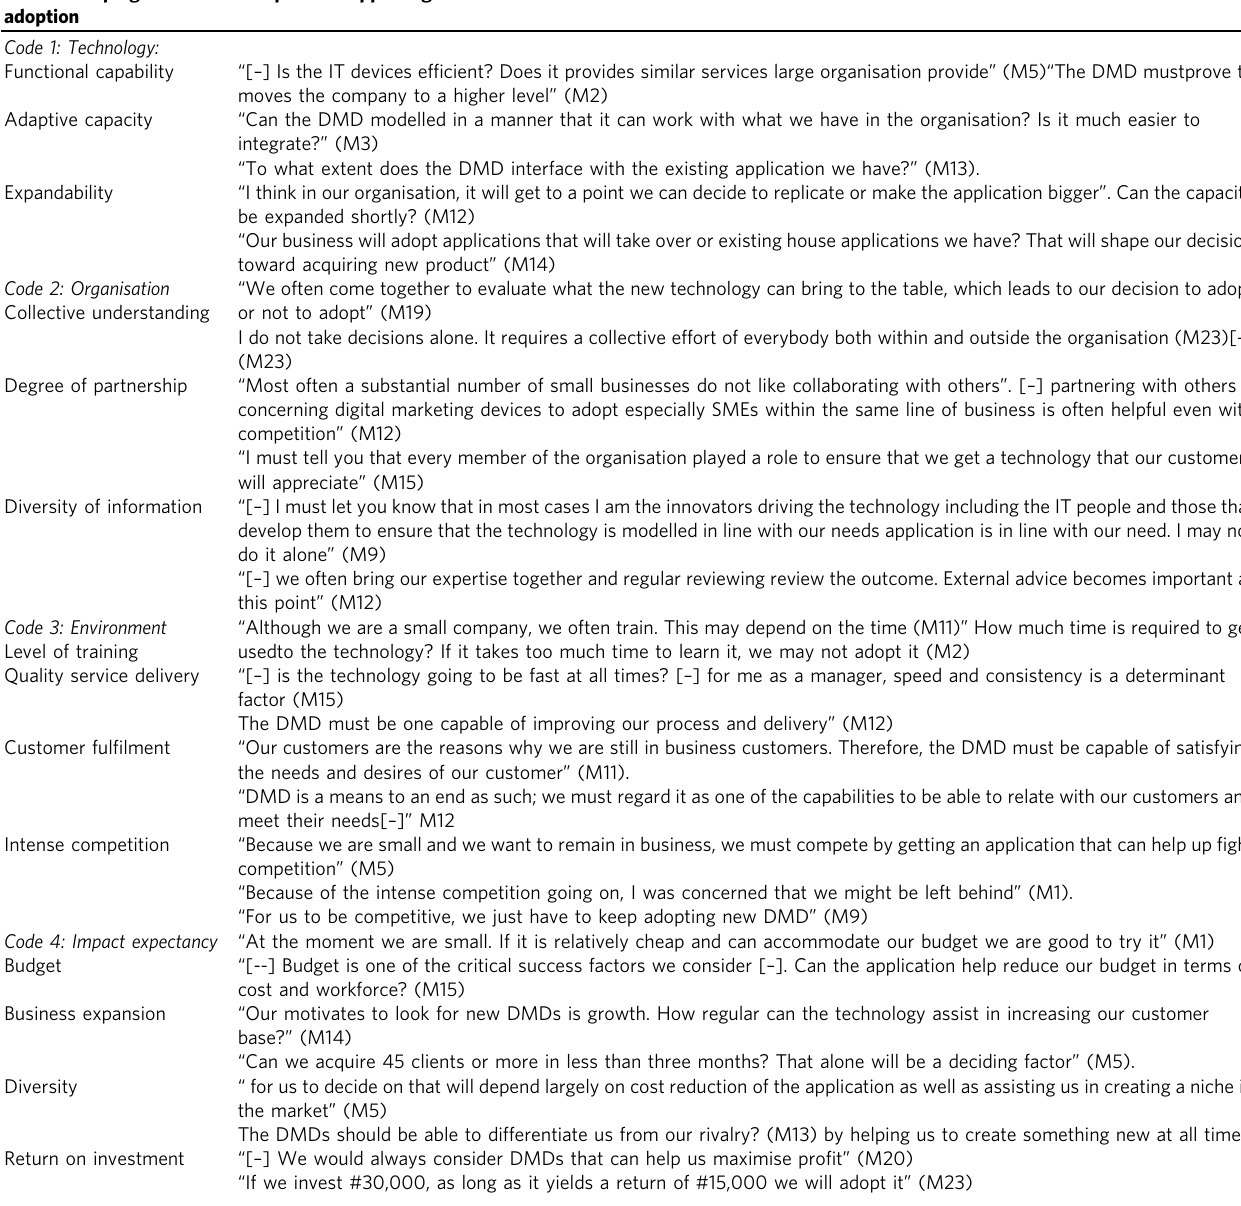
Table 9 critical success factors in fl uencing the adoption of DMD by